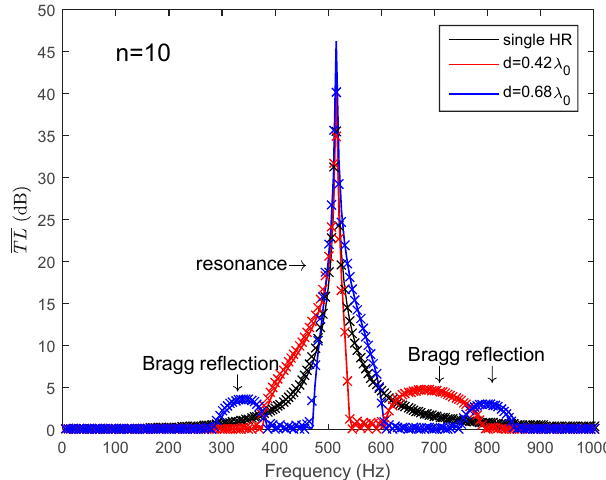
Figure 4. The noise attenuation band of a periodic HR array due to Bragg reflection and HR’s resonance separately (lines represents the theoretical predictions, and dotted crossed represent the FEM simulation results).